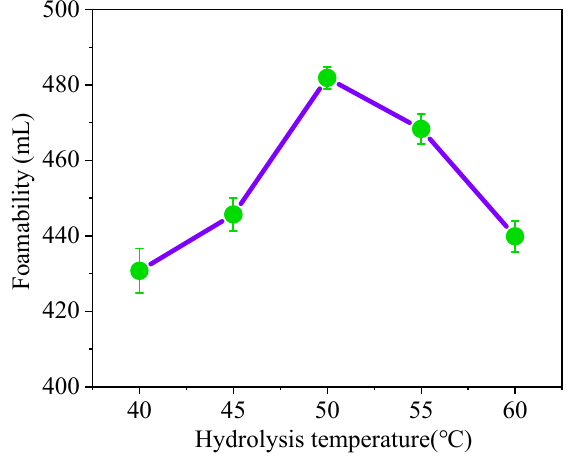
Figure 2. Effect of hydrolysis temperature on foaming ability.